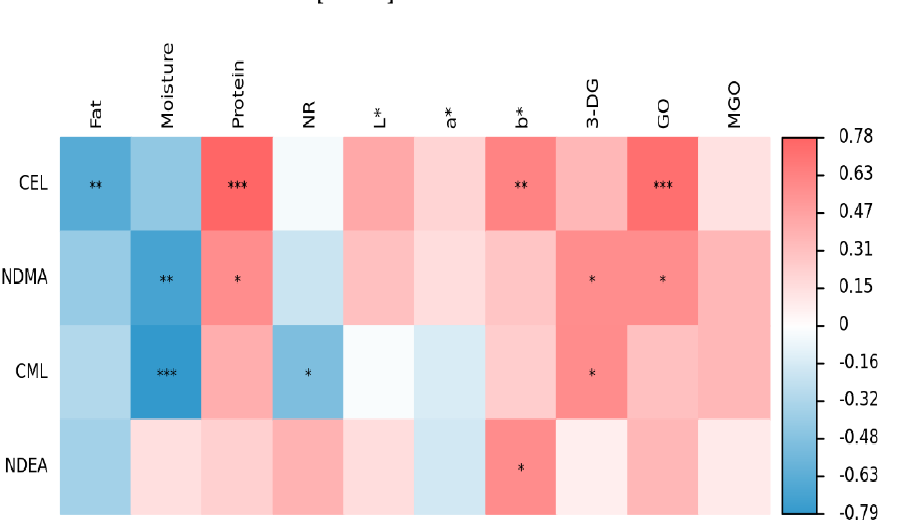
Figure 8. Correlation analysis: * indicates significant; ** indicates highly significant; *** indicates most significant. N ε -carboxymethyl lysine (CML), N ε -carboxyethyllysine (CEL), methylglyoxal (MGO), glyoxal (GO), 3-deoxyglucuronide (3-DG), N-nitrosodimethylamine (NDMA), N-nitrosodiethylamine (NDEA) and nitrite residue (NR).